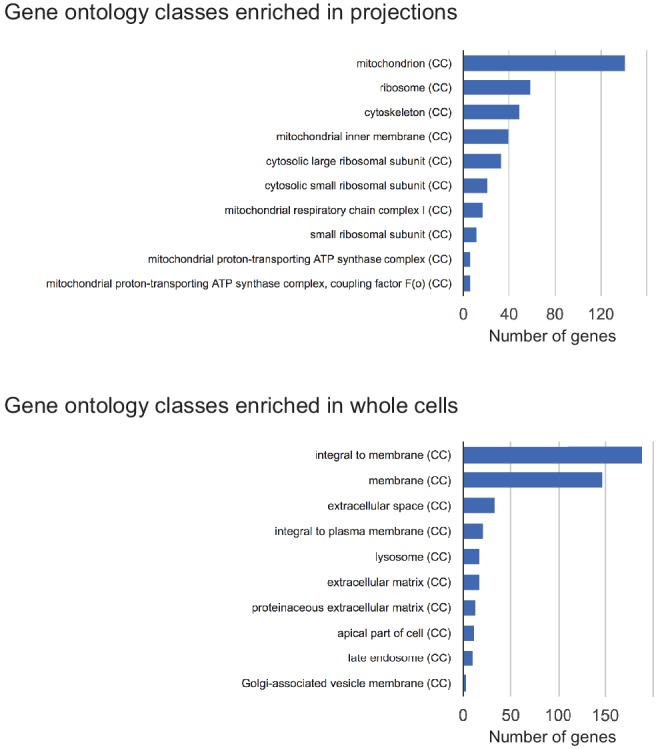
Gene ontology classes enriched in projections and whole cells.Gene ontology classes significantly represented by genes enriched in projections or whole cells. CC = Cellular Component sub-ontology classification.